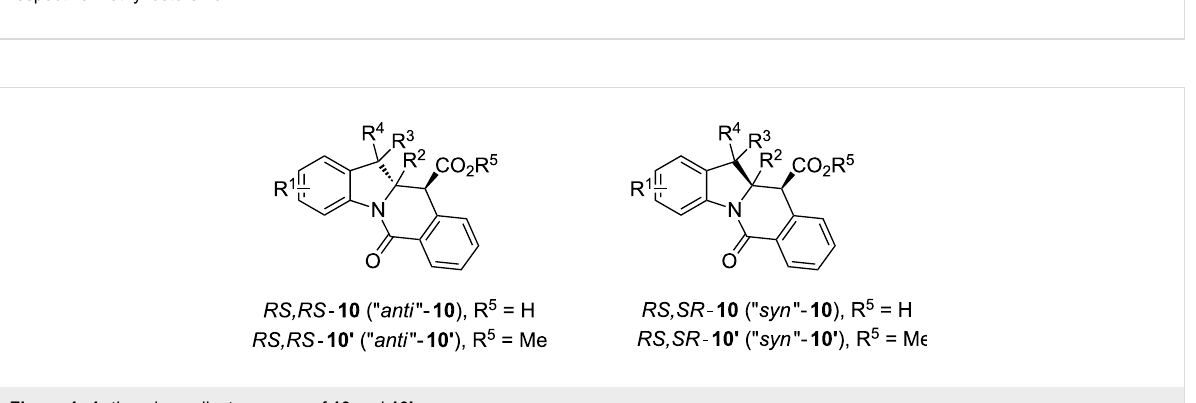
Figure 4: Anti - and syn -diastereomers of 10 and 10' .